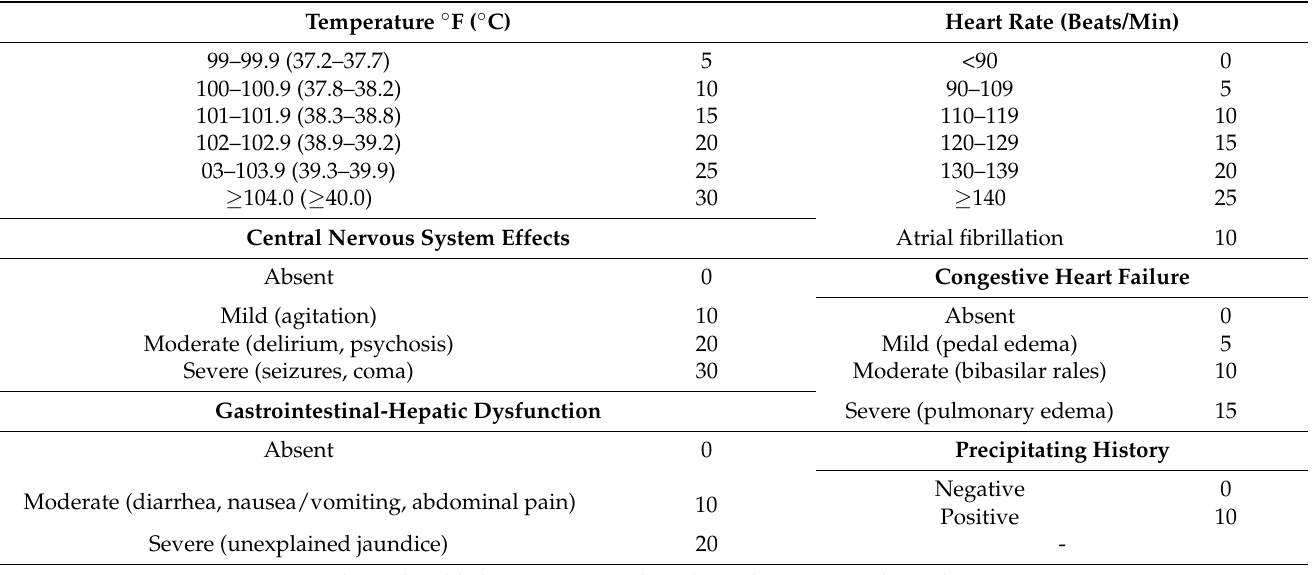
Table 1. The Burch–Wartofsky point scale. The Burch–Wartofsky point scale is widely used as a diagnostic tool for thyroid